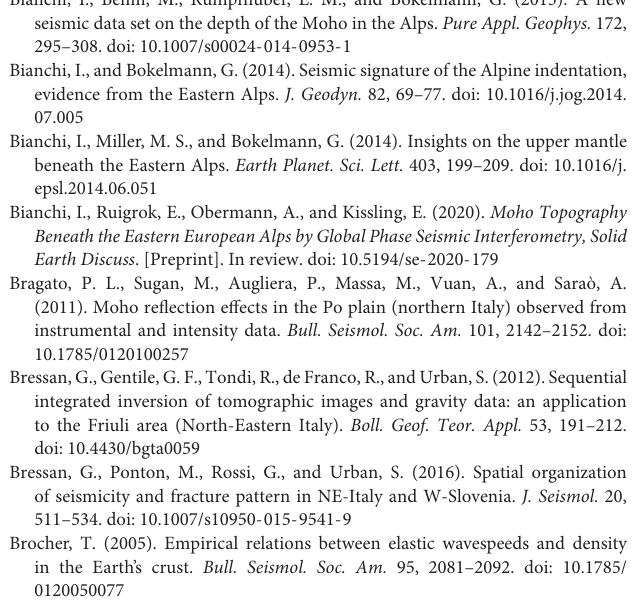
Supplementary Figure 1 | Three month correlograms with the SNR value of higher than 5 between station D024 (the blue circle in Figure 1 ) and other contemporaneously operating stations. Supplementary Figure 2 | Synthetic 1D velocity inversion tests. The True and the inverted models are shown by cyan and red, respectively. Supplementary Figure 3 | Four examples of the inverted 1D S-wave velocity profiles and their sensitivity kernels. Locations of the 1D profiles are mentioned in the panels. Supplementary Figure 4 | Depth slices showing the absolute S-wave velocity values at 5, 10, 15, 20, 25, 30, 35, and 40 km. Location of the Permian magmatic rocks observed at the surface is shown in (A) . SPMR–Surface Permian magmatic rocks. Supplementary Figure 5 | Depth slices showing the relative change in the S-wave velocities of SEA-Crust (this study) with respect to NAC (Magrin and Rossi, 2020). The relative change is calculated as [(SEA-Crust–NAC)/NAC]. FP, Friuli Plain; VP, Venetian Plain; PO, Po Plain. Supplementary Figure 6 | Depth slices showing the relative change in the S-wave velocities of SEA-Crust (this study) with respect to KST18 (Kästle et al., 2018). The relative change is calculated as [(SEA-Crust–KST18)/KST18]. FP, Friuli Plain; VP, Venetian Plain; PO, Po Plain. Supplementary Figure 7 | Depth slices showing the relative change in the S-wave velocities of NAC (Magrin and Rossi, 2020) with respect to KST18 (Kästle et al., 2018). The relative change is calculated as [(NAC-KST18)/KST18]. FP, Friuli Plain; VP, Venetian Plain; PO, Po